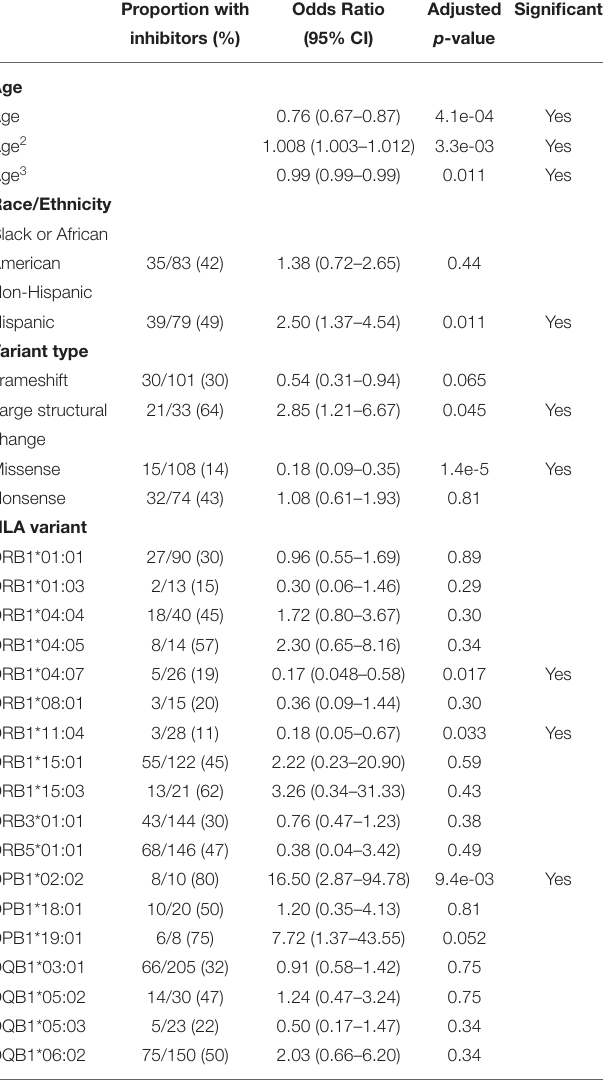
TABLE 4 | Multivariate model results—severe HA participants. TABLE 5 | Multivariate model results—all HLA-typed participants. Proportion with Odds Ratio Adjusted